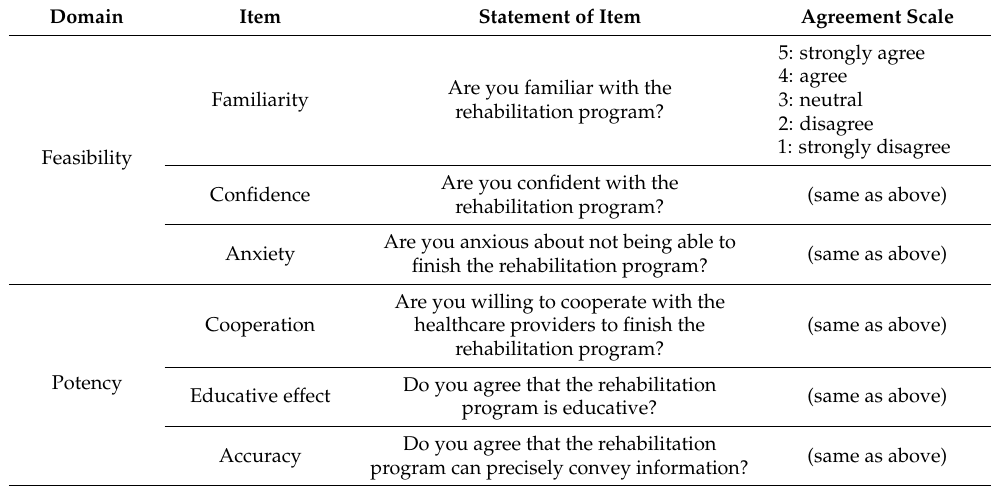
Table 1. Questionnaire items used to assess the perceived feasibility and perceived potency in this